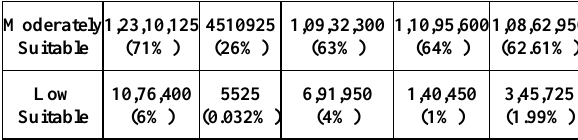
Table 11. Suitable area of Cereals over agricultural